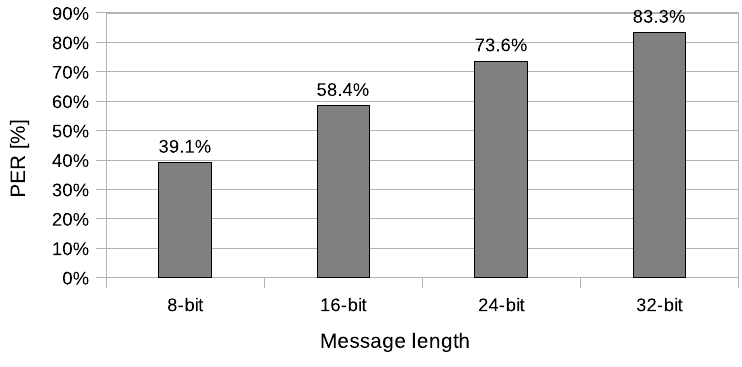
Figure 14. Measurement of the bit error rate (IEEE 802.11n; One-informed).